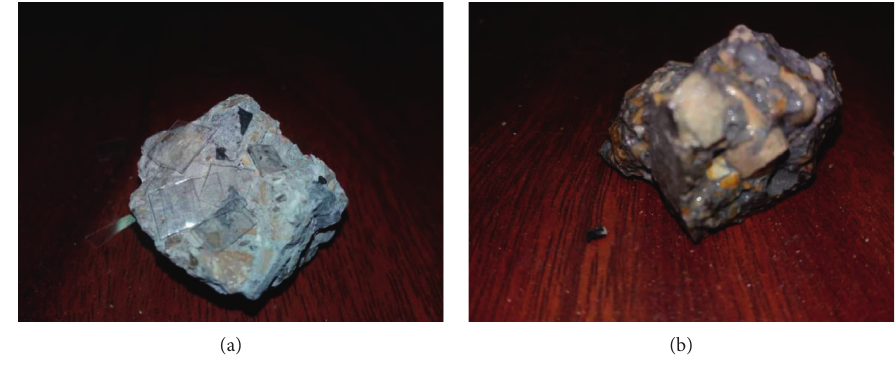
Figure 2: (a) Uncoated CRCAs and WPB; (b) CRCAs coated with